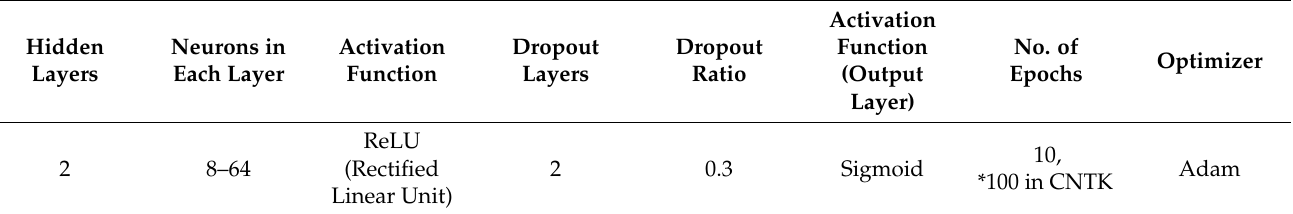
Table 2. Applied Hyper-Parameters for NN Model Training.